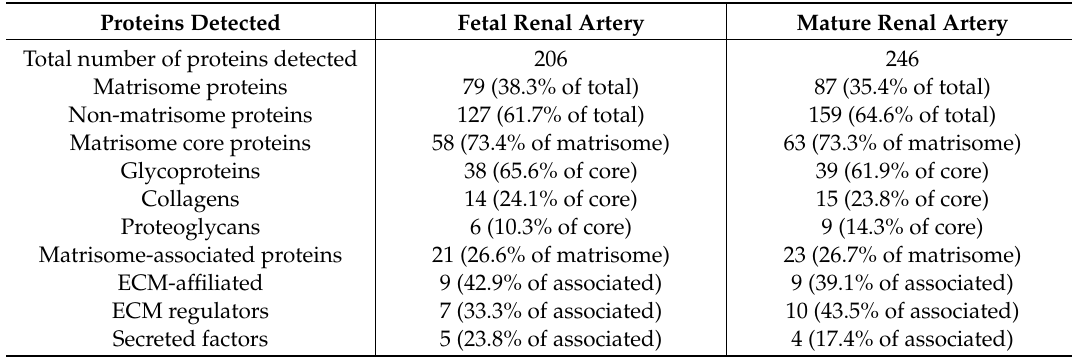
Table 1. Number of genes detected in the fetal and mature renal artery group, divided into matrisome (ECM) proteins and non-matrisome proteins. Within the group of matrisome proteins, di ff erent compartments are recognized as defined by the matrisome project: http: // web.mit.edu / hyneslab / matrisome / . Core matrisome proteins comprise the building blocks of the ECM and include collagens, glycoproteins, and proteoglycans. In addition, matrisome-associated proteins are comprised of ECM binding proteins, which include ECM-a ffi liated proteins, ECM regulators, and secreted factors. Proteins were present in at least 2 out of 3 pools in both fetal and mature pooled